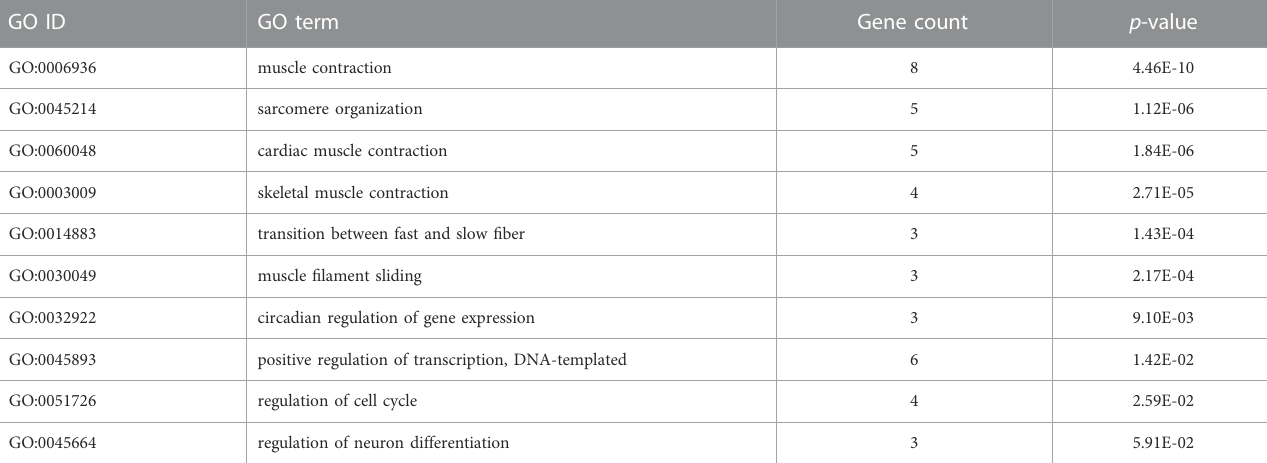
TABLE 5 Biological process GO terms of differentially expressed transcripts in common between the cortisol vs. eplerenone/cortisol groups. GO ID GO